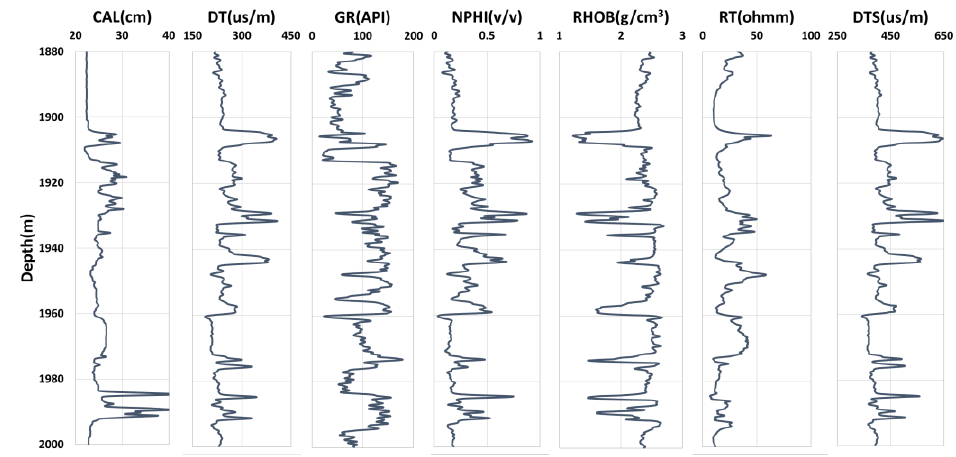
Figure 5. Well logging graph of Well N.